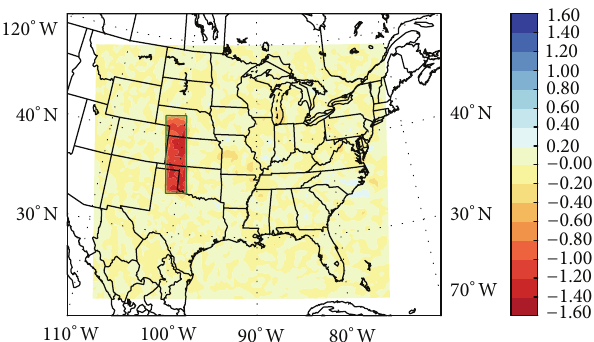
Figure 3: The wind farm is within the green rectangle. The average wind difference at 102 m between the simulation with 2.5 Wm −2 of 2 MW turbines minus the simulation without turbines is shown.